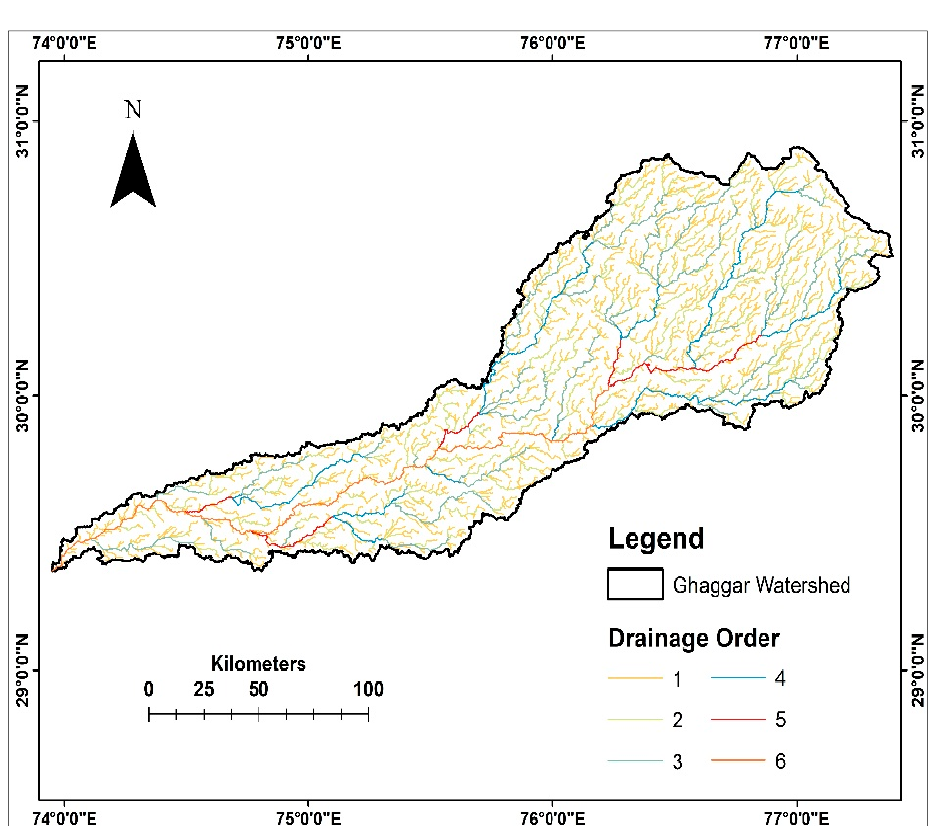
Figure 7. Drainage order map of the study area.